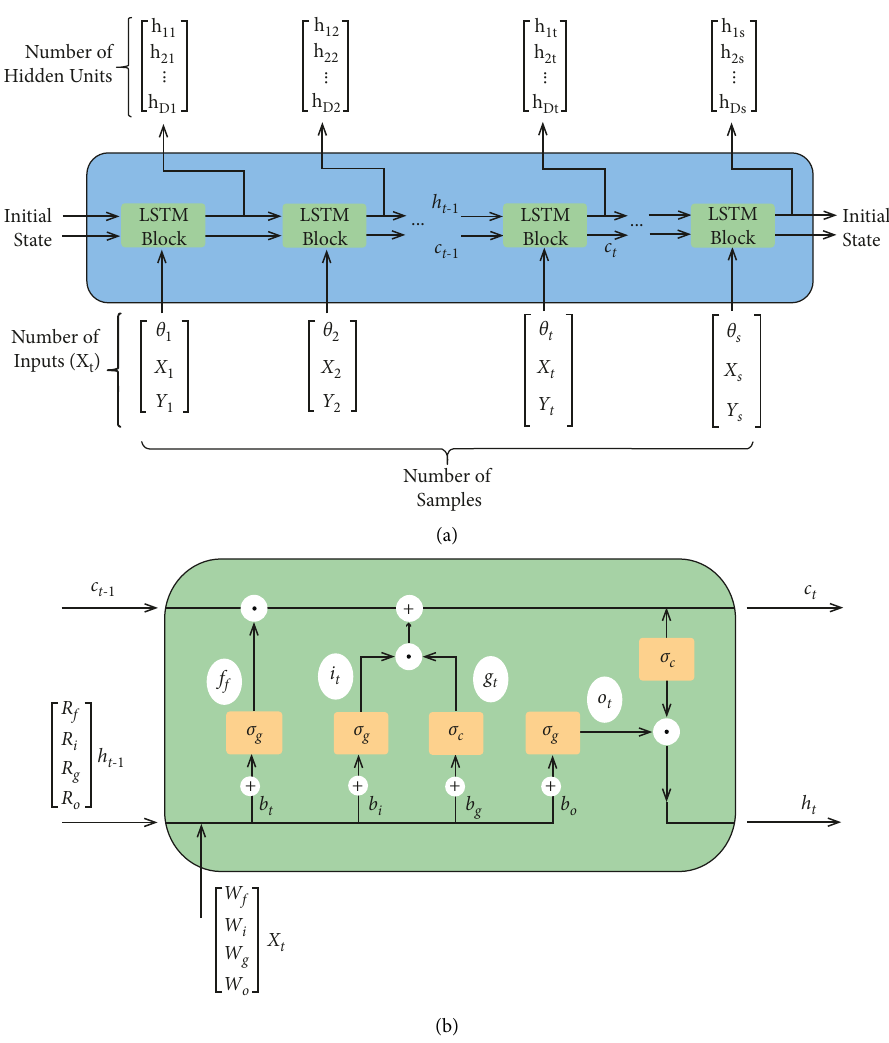
Figure 3: LSTM ANN: (a) architecture; (b) LSTM